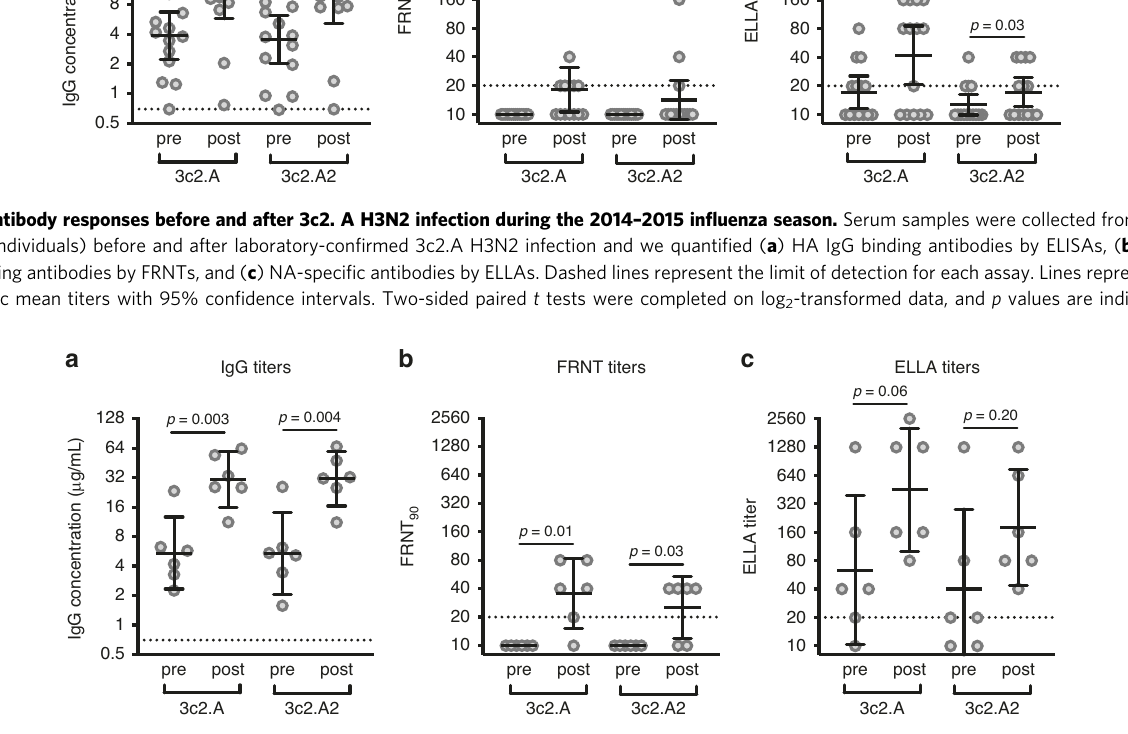
Fig. 3 Antibody responses before and after 3c2.A H3N2 infection during the 2016 – 2017 in fl uenza season. Serum samples were collected from adults ( n = 6 individuals) before and after laboratory-con fi rmed 3c2.A H3N2 infection and we quanti fi ed a HA IgG binding antibodies by ELISAs, b neutralizing antibodies by FRNTs, and c NA-speci fi c antibodies by ELLAs. Dashed lines represent the limit of detection for each assay. Lines represent the geometric mean titers with 95% con fi dence intervals. Two-sided paired t tests were completed on log 2 -transformed data, and p values are